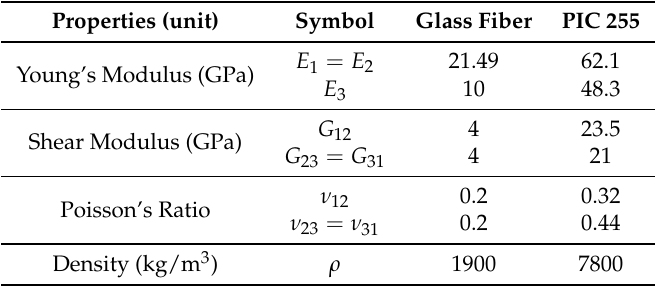
Figure 1. Overall energy harvesting model of flag-flutter subjected to axial flow. Table 3. Material